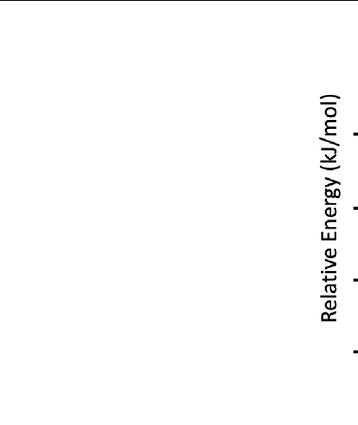
FIGURE 3 | Sketch of a simple reaction mechanism between the AB molecule and the reactive C species: all the required conditions for a reaction occurring in the ISM are highlighted. Relative energies here considered (numbers in black) are ZPE-corrected electronic